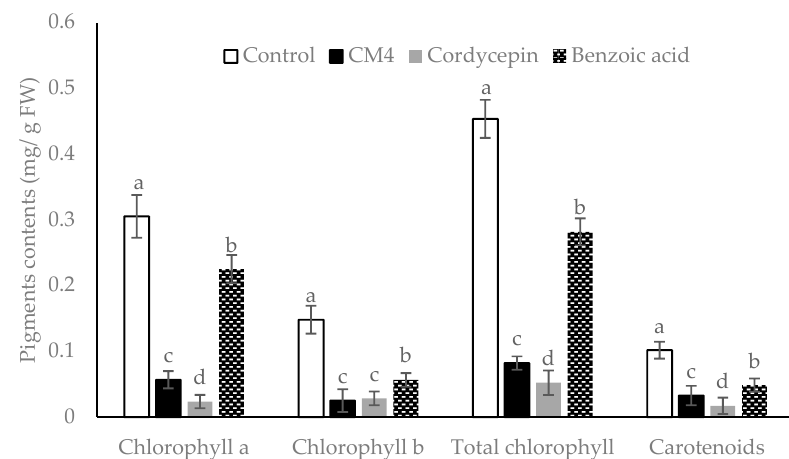
Figure 2. Pigment contents of radish treated with CM4 fraction, synthetic cordycepin and BA at 0.04 mg / mL. Columns with di ff erent superscript letters ( a,b,c,d ) in bars showed significant di ff erences at p < 0.05 by Fisher’s test.